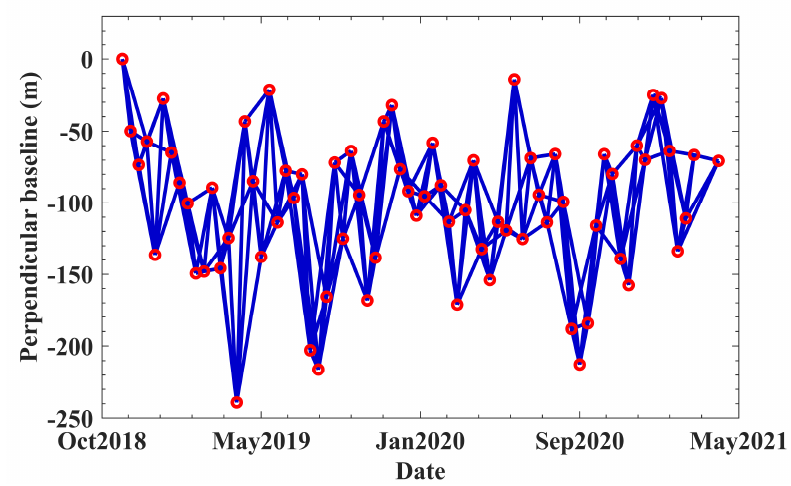
Figure 5. Chart showing 210 redundant SB interferograms.